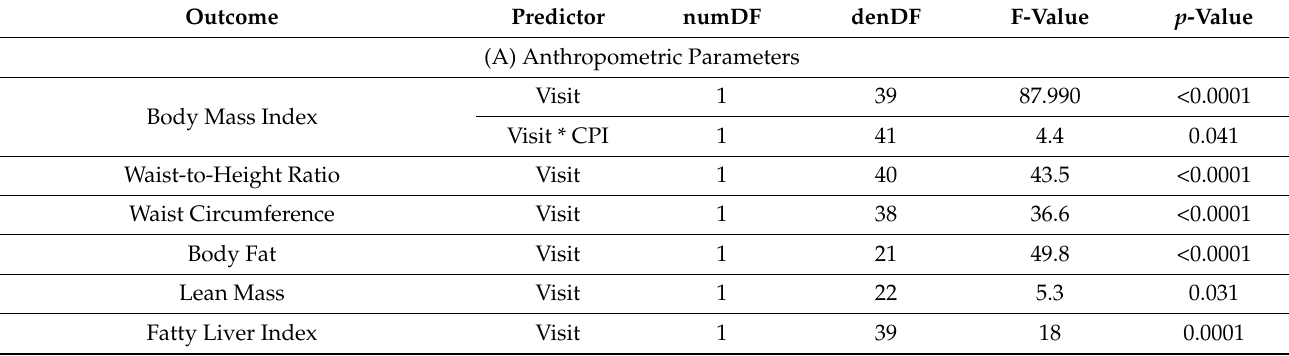
Table 1. Mixed model results, grouped by types of outcome parameters. For each outcome of interest, models with main effects of visit (baseline and after two weeks) and group (caloric restriction alone, and in combination with clinical- psychological intervention—CPI), as well as their interaction effect were calculated. Only significant effects are listed. Numerator and denominator degrees of freedom (numDF, denDF), F and p -values are reported. Effects of visit indicate similar results in both treatment groups and thus caloric restriction. Uncorrected results are displayed. Interaction effects are indicated by